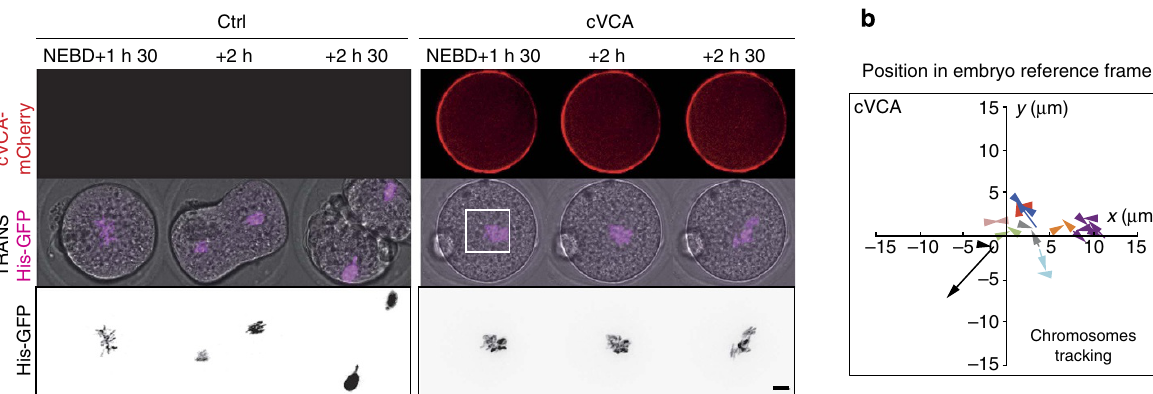
Figure 8 | Maintenance of the central position of the metaphase plate does not rely on tension but could depend on a viscous cytoplasm. ( a ) Embryos expressing His–RFP alone (left panels) or together with cVCA (right panels). Upper panel: cVCA (red), one Z-plane is shown; middle and lower panels: His– RFP, purple or black, Z-projection over 20 m m. One frame is shown every 30min. Scale bar, 10 m m. ( b ) Graph showing the position of the centroid of the chromosomes in the referential of the embryo (0 being the centre) from metaphase to anaphase for representative embryos expressing cVCA. The scale is represented by the white box in Fig. 8a. Each colour represents an embryo. The arrows point to the last position recorded before anaphase. One time point is shown every 20 or